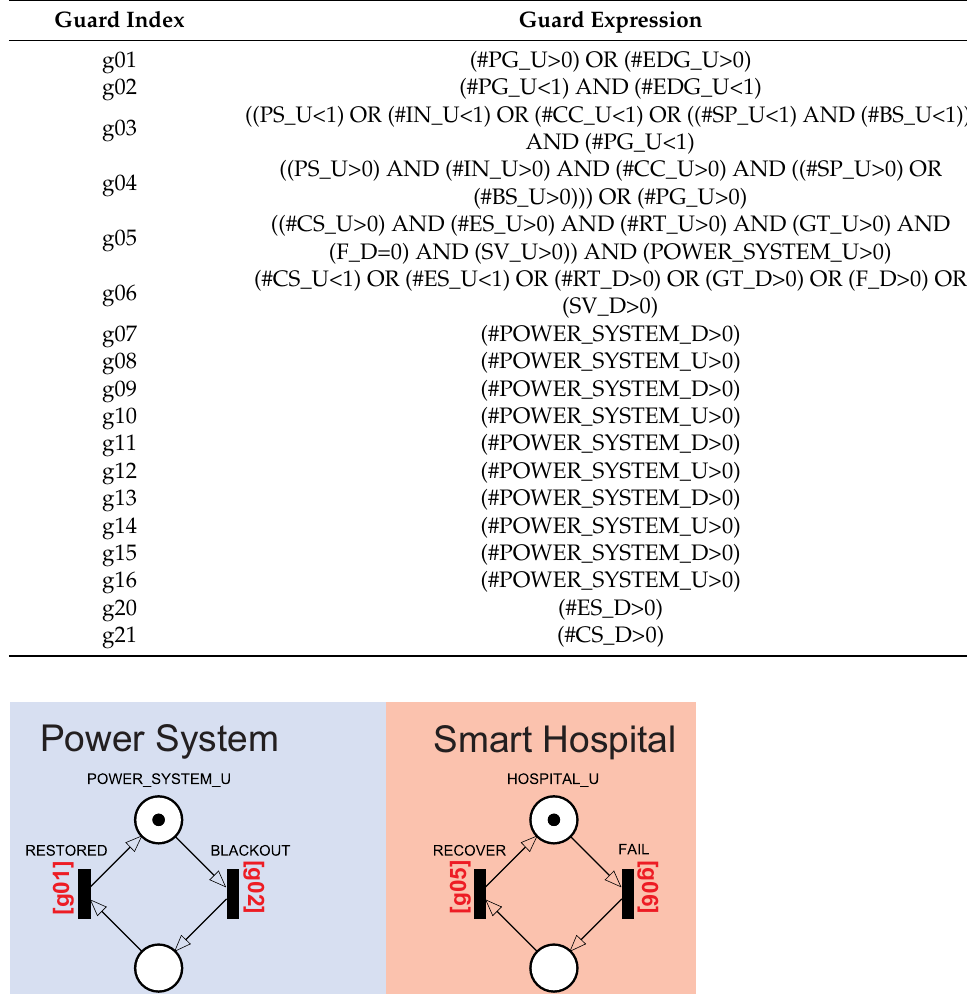
Table 3. Guard expressions for model A transitions.